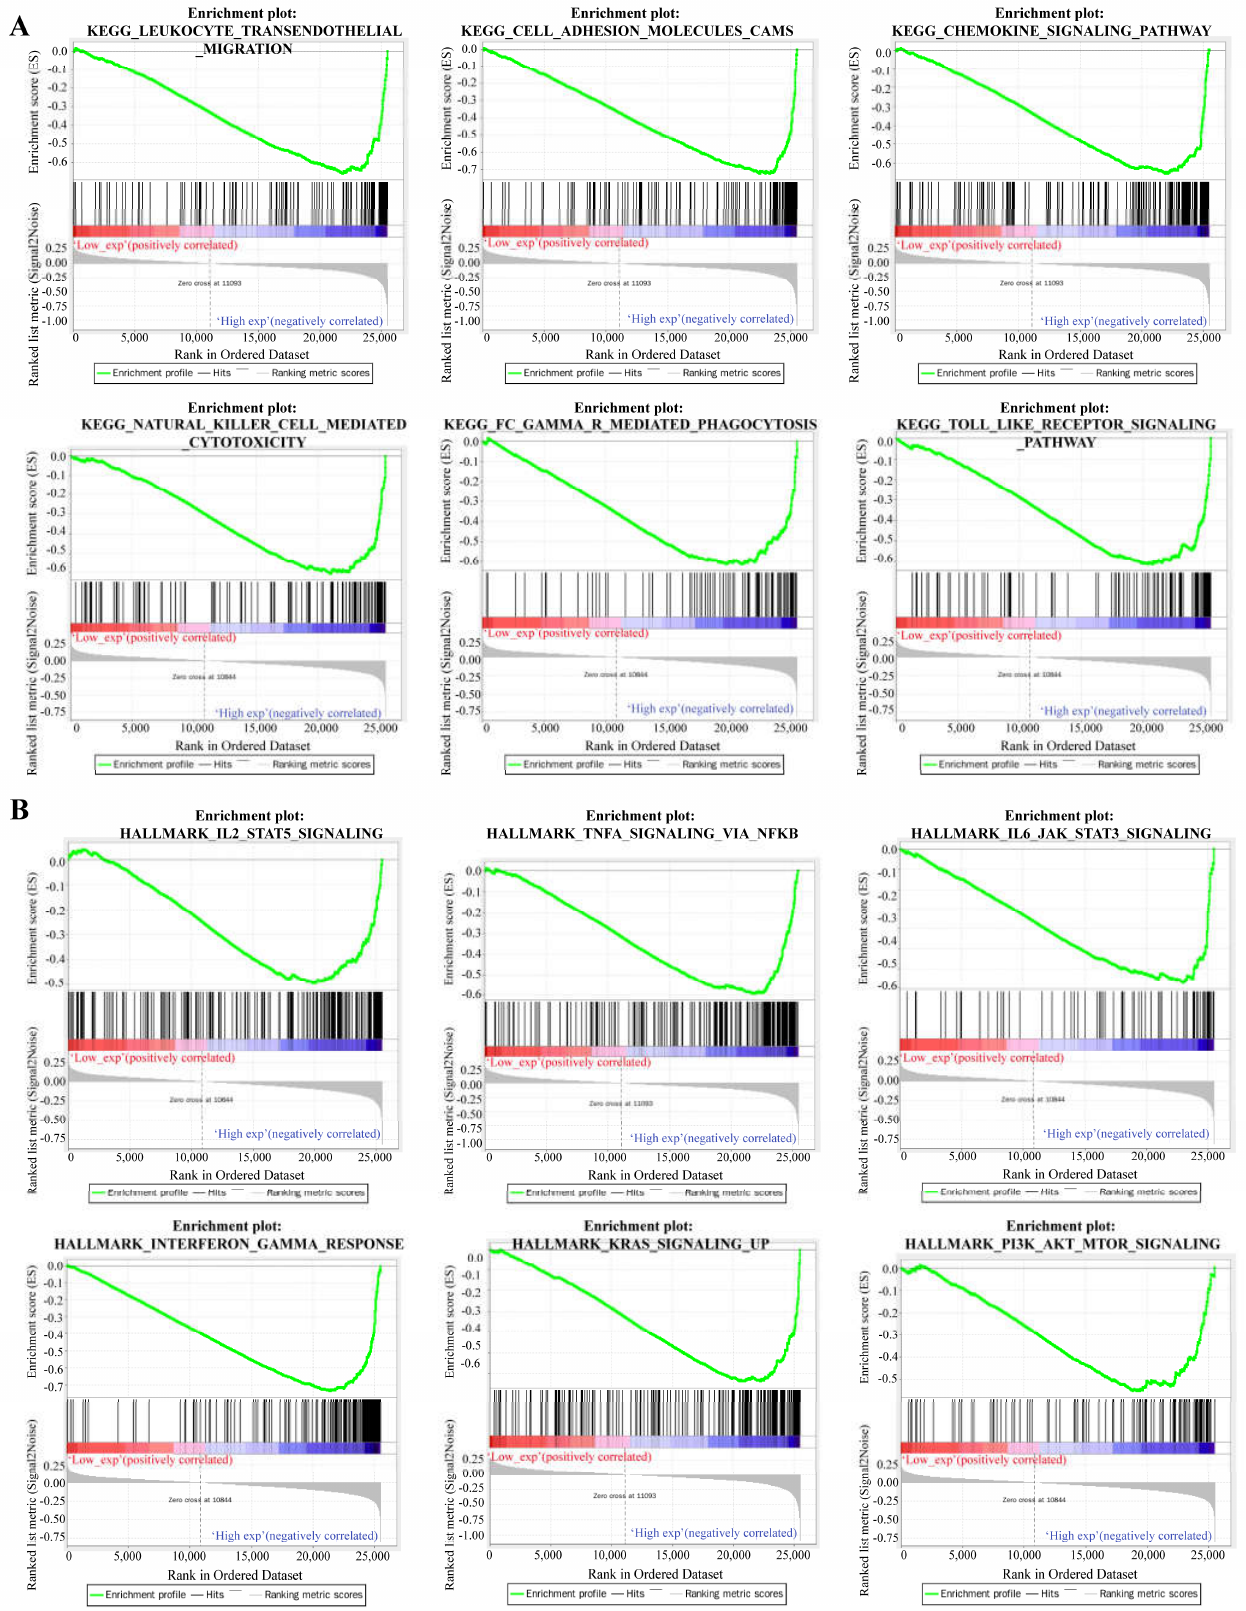
Figure 5. Gene set enrichment analysis (GSEA) for RAB42. KEGG pathways ( A ) and HALLMARK pathways ( B ).